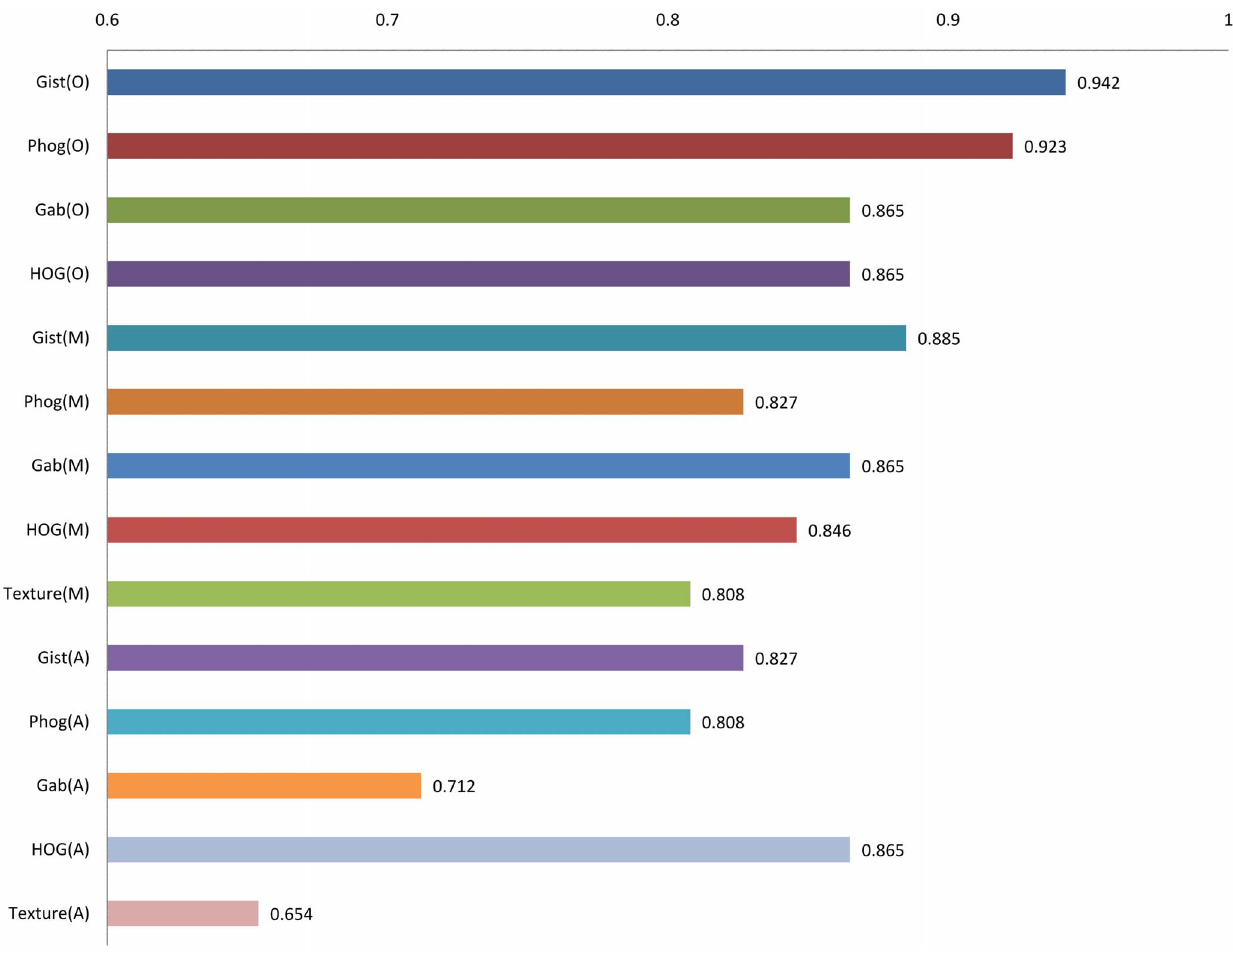
Figure 6. Comparison of performance for various features from whole, manually segmented, and automatically segmented CXRs.